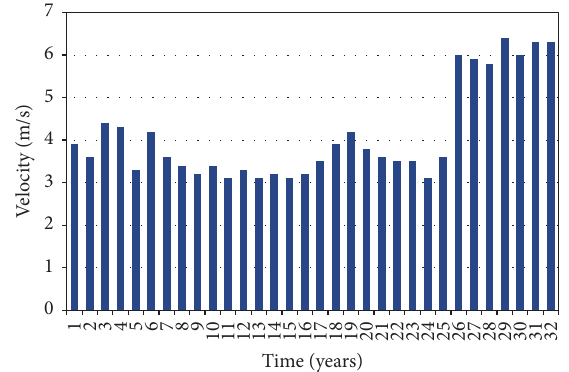
Figure 1: Annual maximum wind speed for